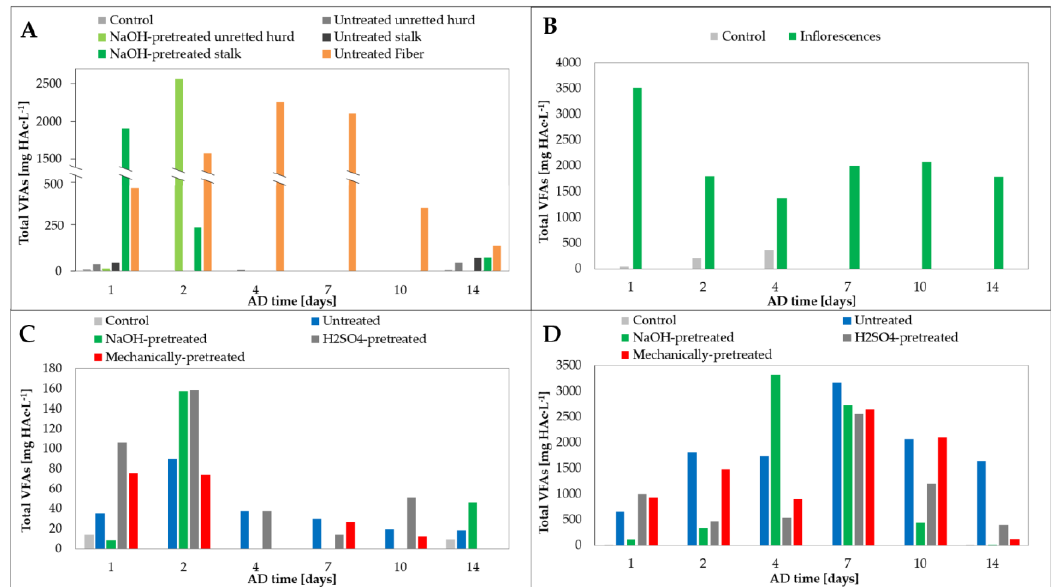
Figure 4. Evolution of the total volatile fatty acids observed during the anaerobic digestion of the untreated unretted hurds, stalks and fibers and of the NaOH-pretreated unretted hurds and stalks ( A ), the untreated inflorescences ( B ), the NaOH-, H 2 SO 4 - and mechanically pretreated retted hurds ( C ) and the untreated, NaOH-, H 2 SO 4 - and mechanically pretreated mix of leaves and inflorescences ( D ). The volatile fatty acids concentrations of the untreated retted hurds shown in panel C refer to those already reported in the study of Papirio et al. [27].